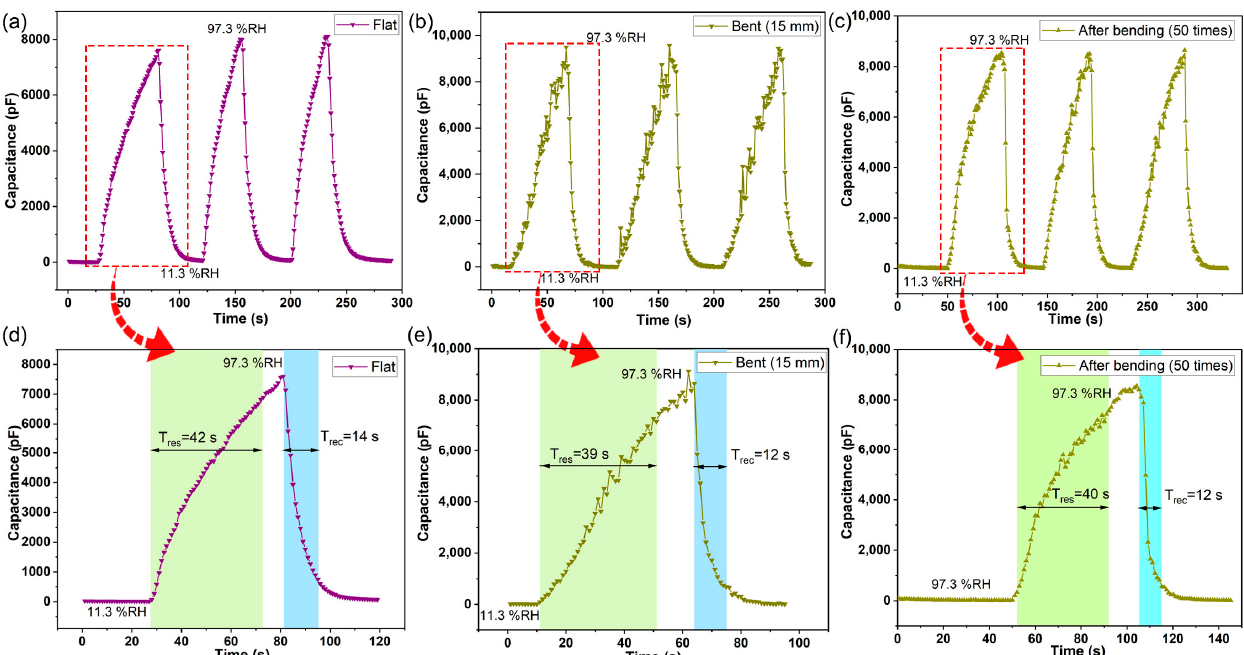
Figure 6. The response and recovery performance of the sensor at di ff erent states. The repeatability of the as-fabricated sensor under fl at ( a ), bending ( b ), and after bending 50 times ( c ) states; the dy- namic response and recovery time curves of the as-fabricated sensor under fl at ( d ), bending ( e ), and after bending 50 times ( f ) states. response and recovery time curves of the as-fabricated sensor under flat ( d ), bending ( e ), and after bending 50 times ( f )